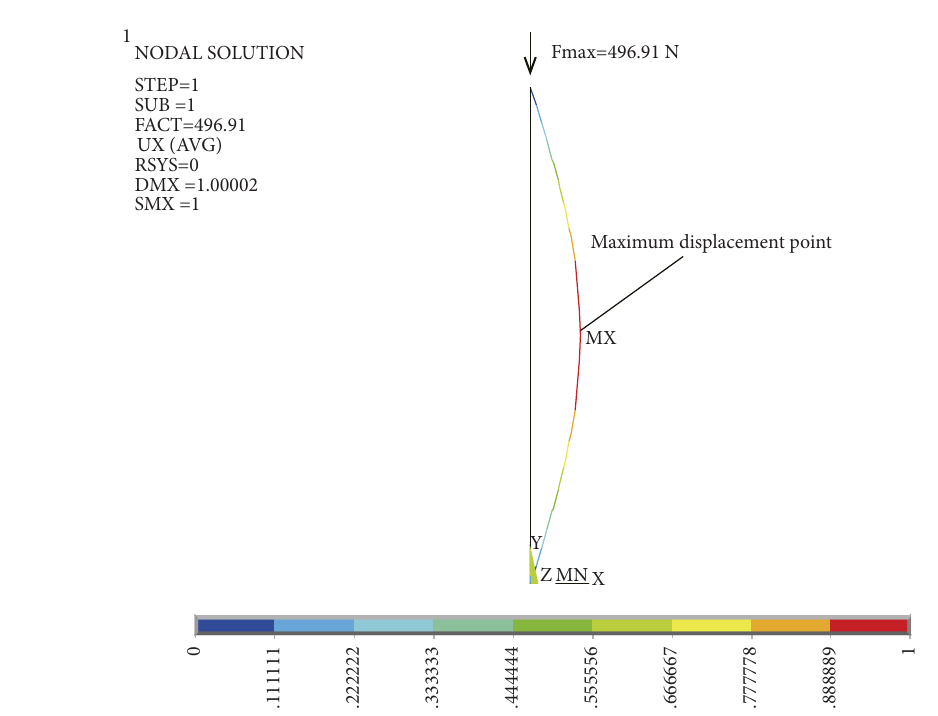
Figure 7: Te frst mode of composite mandrel.